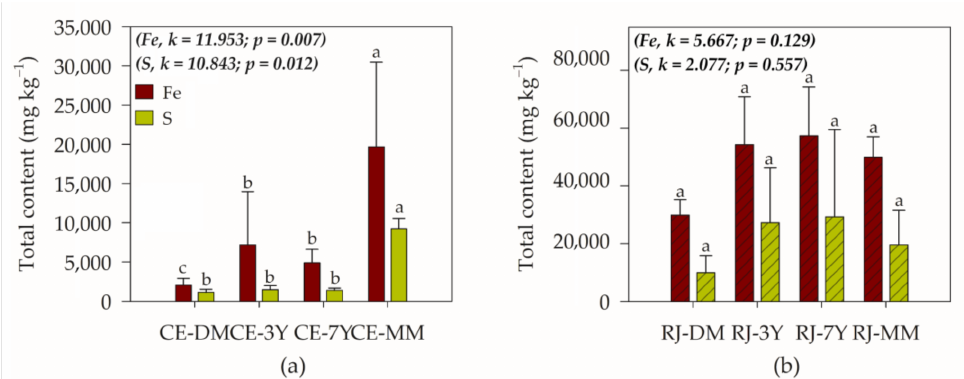
Figure 5. Total Fe and S contents in all studied plots in Cear á ( a ) and Rio de Janeiro ( b ). Different lowercase letters indicate significant differences among variables found by the Kruskal–Wallis test at the 5% probability level, and k values above the critical k (7.8147) indicate statistical